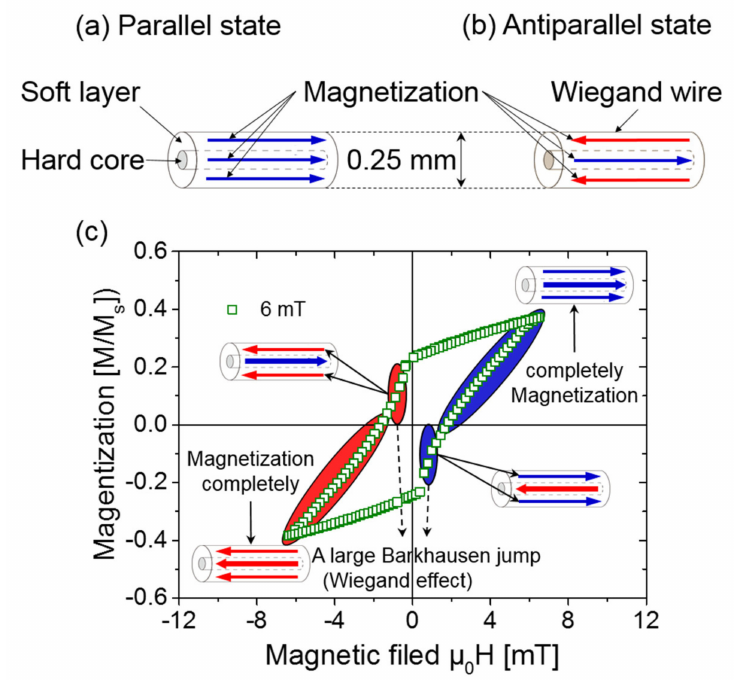
Figure 2. Magnetization states and magnetization curves of the Wiegand wire: ( a ) parallel state; ( b ) antiparallel state and ( c ) magnetization curve (minor loop) of the whole